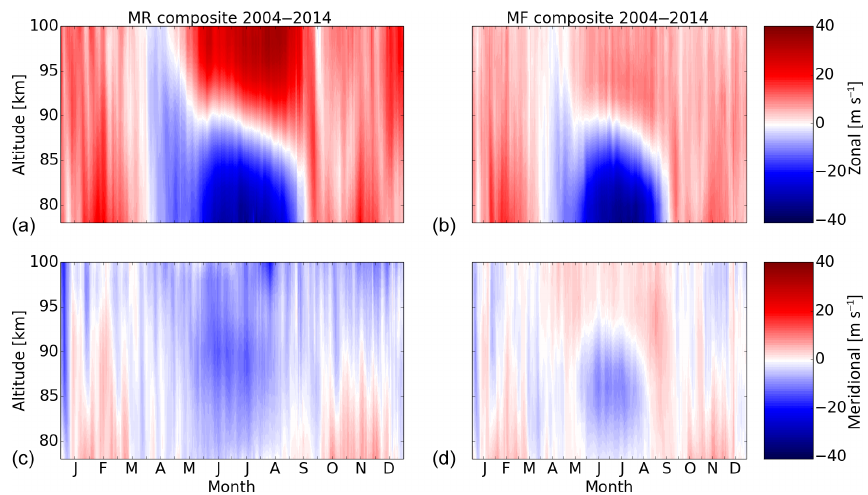
Figure 3. Composite of zonal (a, b) and meridional (c, d) wind component for meteor radar (a, c) and MF radar (b, d) for the years 2004–2014. The data have been smoothed by using a 5-day mean centered at the respective day.